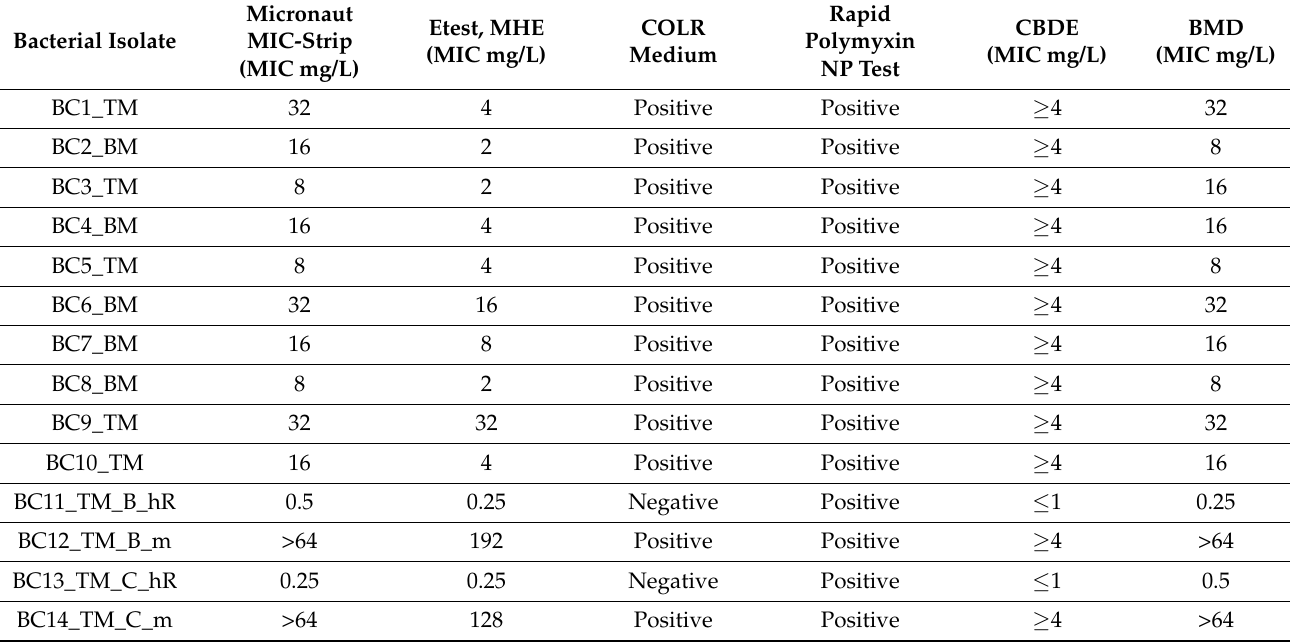
Table 2. Colistin testing results obtained using different assays.